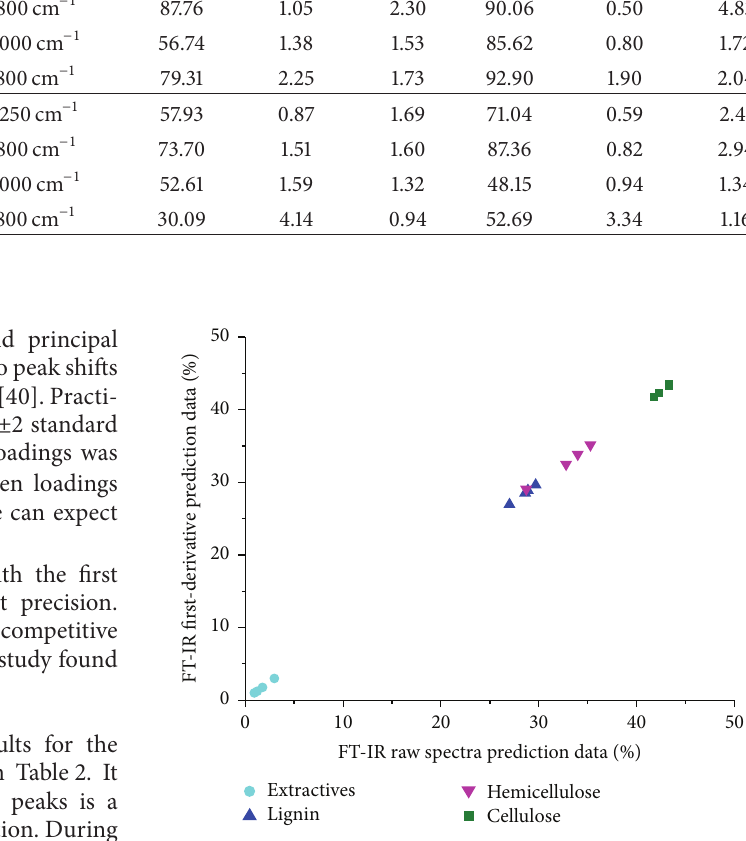
Figure 7: Chemical content (%, w/w) predicted by multivariate models with FT-IR (PLS) for validation